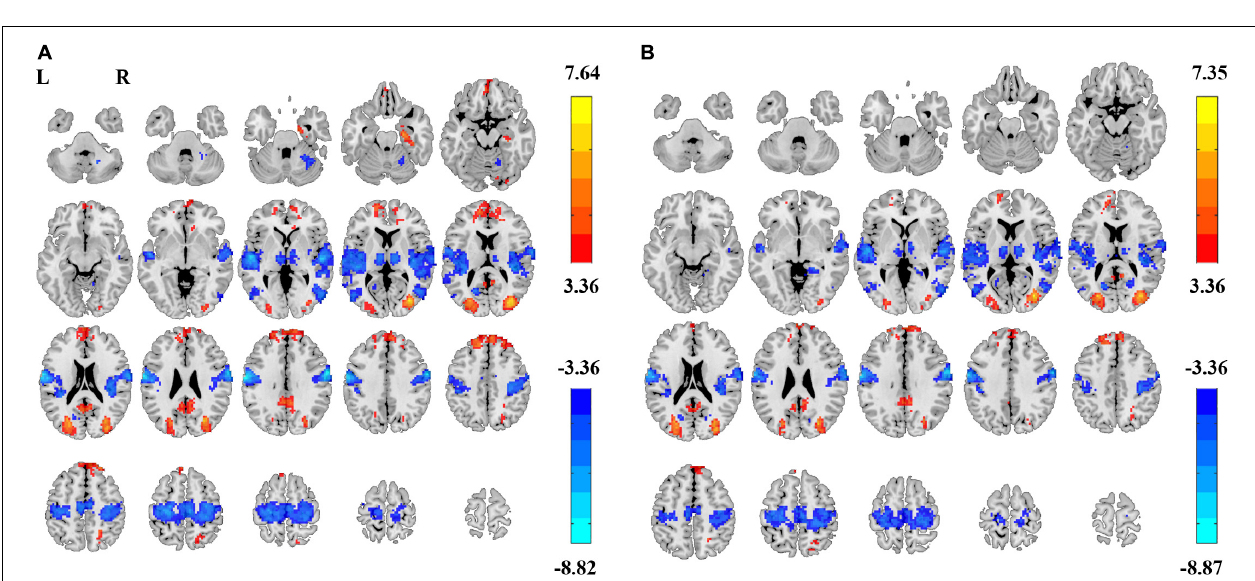
FIGURE 6 | Post-hoc plots of the power spectrum and the linear coefficient b and the normalized power amplitude of EC and EO conditions. The mean power spectrum and slope of all subjects in EC and EO conditions in the sensorimotor cluster (MNI = [60 –3 36]) (A) , the occipital cluster (MNI = [33 –78 12]) (B) , and the parahippocampus (MNI = [–27 –18 –24]) (C) . The difference in the sensorimotor cortex [EC > EO, Panel (A) ] and visual cortex [EO > EC, Panel (B) ] is mainly contributed by the lower frequency band. However, the difference in the parahippocampus [EC > EO, Panel (C) ] is mainly in the higher frequency band. The plots represent averaged values across 145 subjects. Error bars represent standard errors. AU refers to the arbitrary unit. The arrows are the indicators of the location where the power spectrum “cross-over” effect appears.